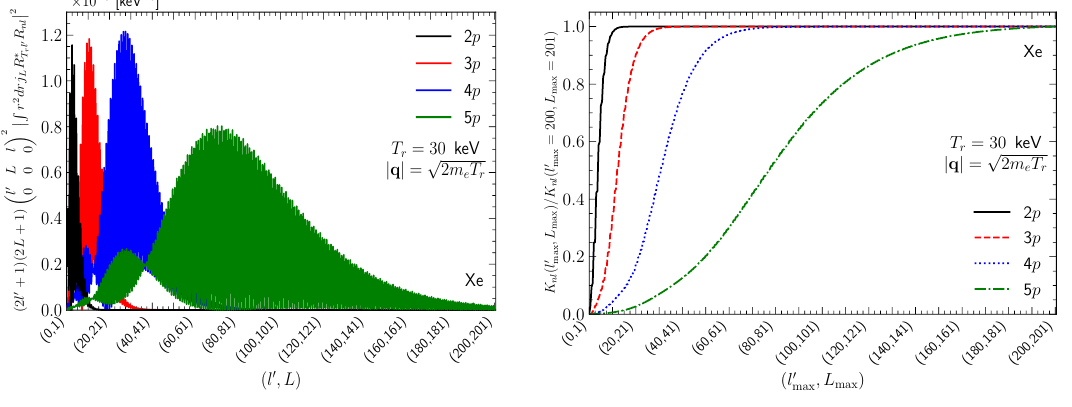
Figure 2 . The left panel shows the non-zero terms of the double summation in (2.15) as a function of l 0 , L . The right panel shows the fraction between the partial sum for a given set of l 0 the total sum with l 0 = 200 , L max = 201 . In both cases, T r = 30 keV and | q | = max lines represents the 2p (black), 3p (red), 4p (blue) and 5p (green) orbitals in the Xe atom. r 2 | R | 2 (black solid) that should appear in normalization integration. While the initial nl